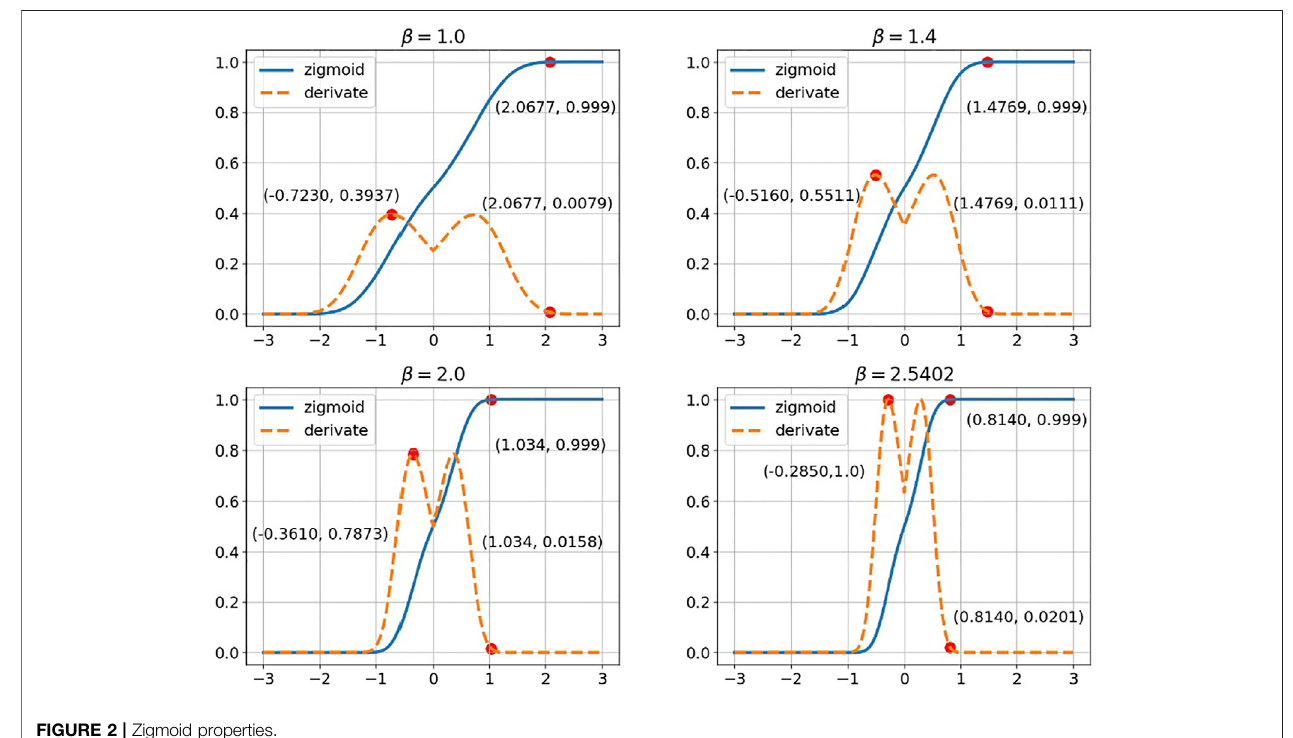
FIGURE 2 | Zigmoid properties.